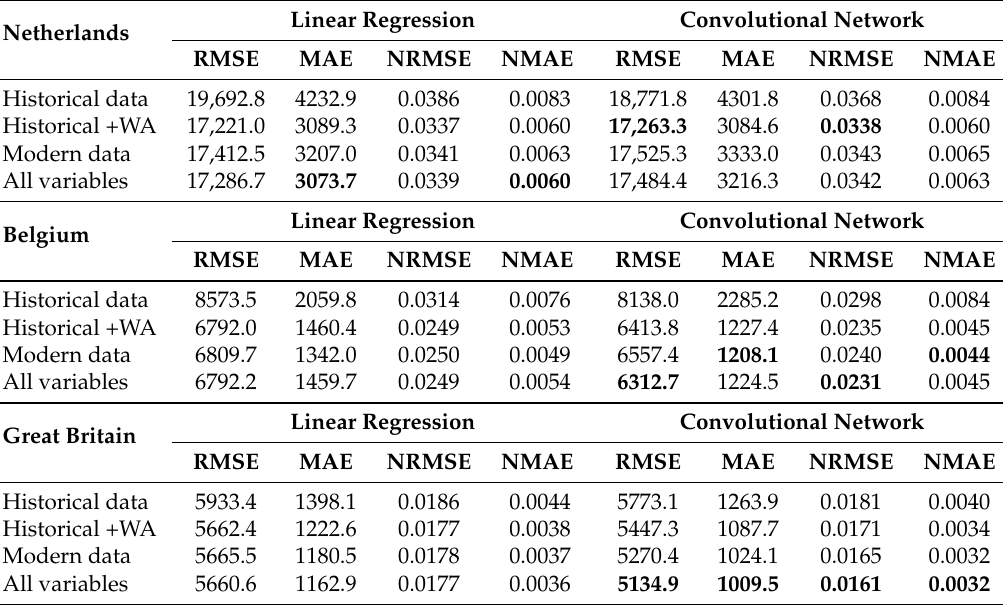
Table 2. Results obtained with different sets of ancillary